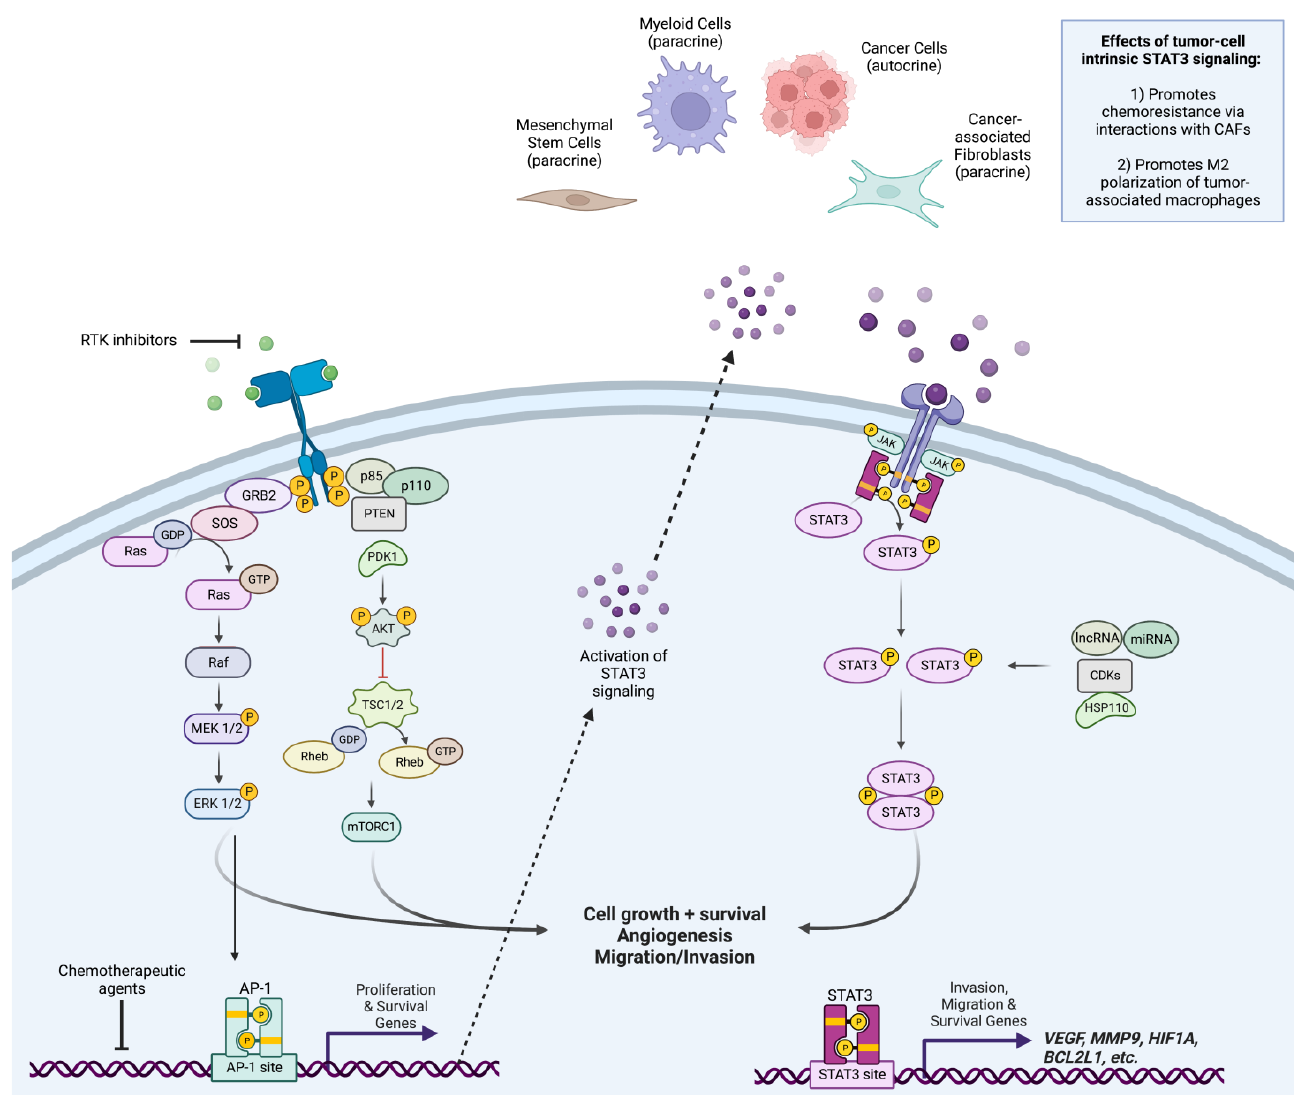
Figure 1. Graphical schematic depicting molecular mechanism of STAT3-mediated acquired drug resistance in response to receptor tyrosine kinases within cancer cells. Adapted from Yang et al. [144].